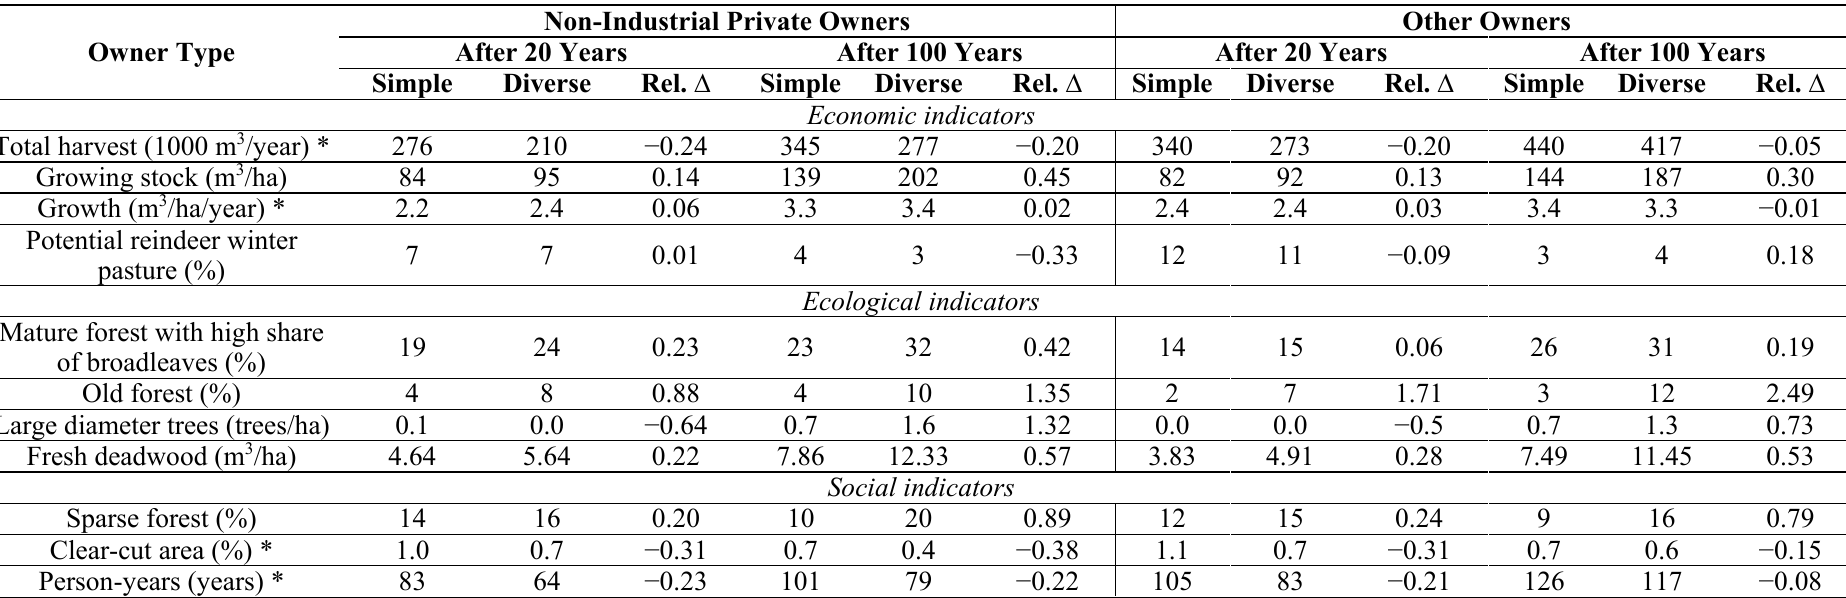
Table 13 . Differences between the Diverse and Simple scenarios for economic, ecological and social indicators after 20 and 100 years of simulation, by ownership category, in Vilhelmina. The relative difference (Rel. ∆) was calculated as: (Diverse-Simple)/Simple. See Table 2 for information on the proportion of different owner